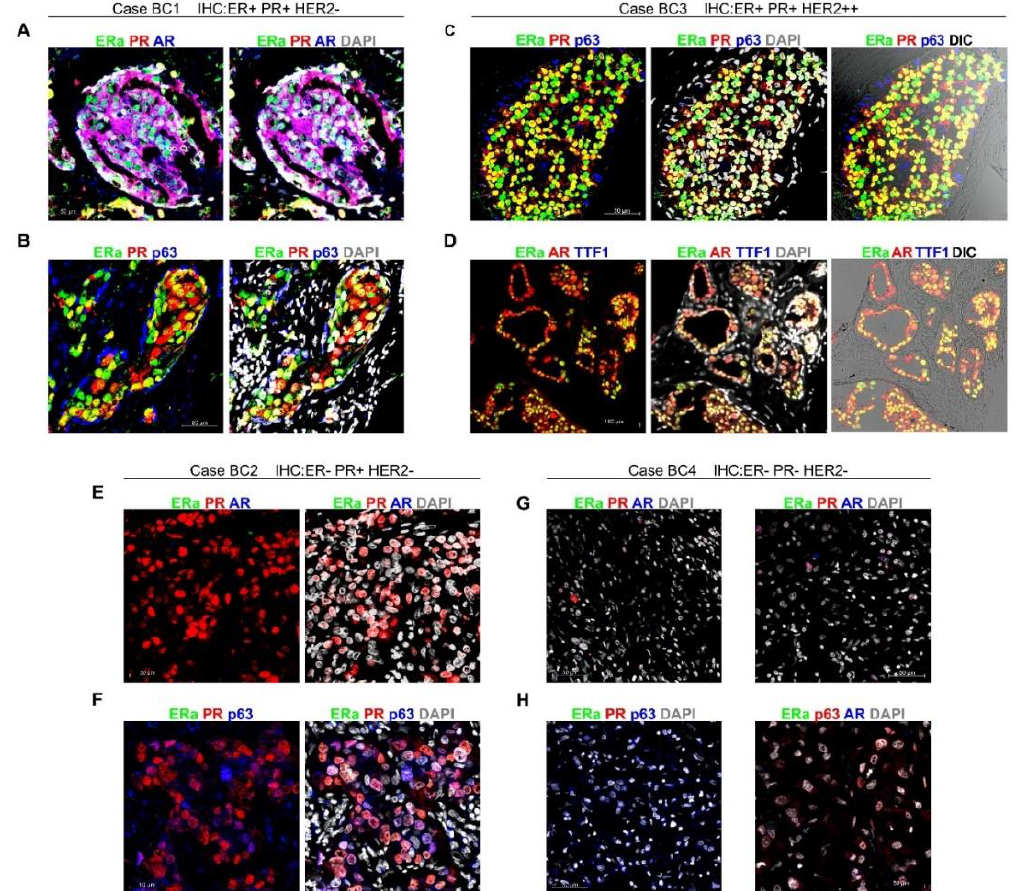
Figure 3. ColNu mIHCF in breast cancer from di ff erent hormone receptor and HER2 status. ( A , B ) BC1 presents ductal carcinoma in situ (DCIS) area maintaining the basal p63 layer. Epithelium co-expresses nuclear ERa with strong whole-cell (cytoplasmic + nucleus) PR and AR localization. In A (top-left), the blended white color indicates overlay in quantity and location of all three receptors. ( C , D ) BC3 is another DCIS area with an intact p63 basal layer. All three receptors, ERa + PR + AR, are co-expressed exclusively in the nucleus, as shown by the blended yellow color in ER + PR ( B ) and in ER + AR ( D ). TTF1 was negative, as were all the other breast cancer cases. ( E , F ) BC2 epithelium (invasive ductal carcinoma) expresses PR exclusively, being negative for both ERa and AR. The PR + population presents a p63 + sub-population. ( G , H ) BC4, a triple negative invasive ductal carcinoma, shows negativity for all three nuclear receptors. The cancer epithelium expresses p63. Shown are two independent fields for each multiple combination of antibodies. The order of antibodies in the consecutive cycles is indicated above each photograph. Pseudocolor was kept constant: green for the 1st, red for the 2nd, and blue for the 3rd cycle. DAPI was included in the mounting medium and reveals the nuclei. DIC is a plane obtained with transillumination for di ff erential interfering contrast-Nomarski and reveals tissue structure.